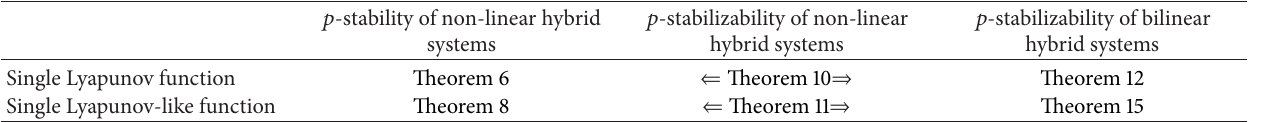
Table 1: The relationship between the theorems proposed in the